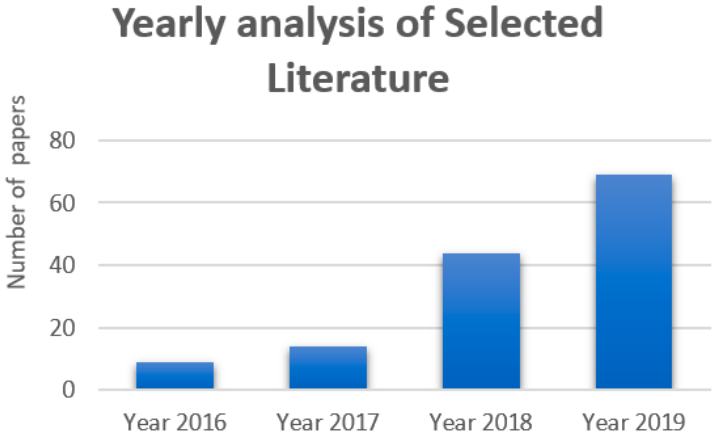
Figure 4. Figure illustrates the year wise distribution of published paper in the blockchain domain.